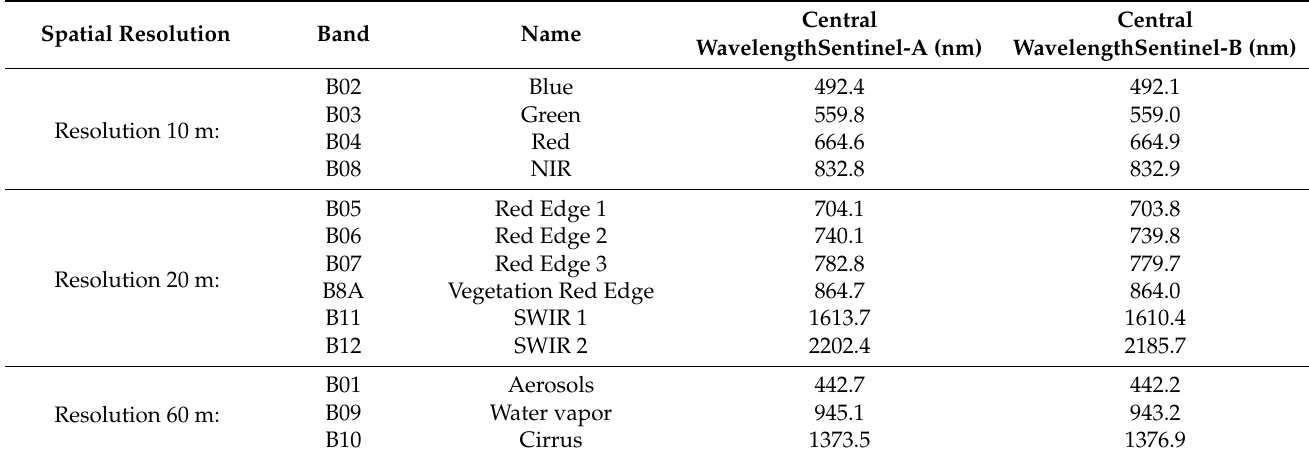
Figure A1. Sentinel-2 data (total, 37 images) acquired during the 2018 and 2019 crop seasons (C1, winter wheat; C2, maize; C3, alfalfa) and the ground-LAI acquisitions in the experimental sites F1, F2, and F3, around Pisa; DOY is day of the Year. Table A1. Wavelength and spatial resolution of Sentinel-2 spectral bands.